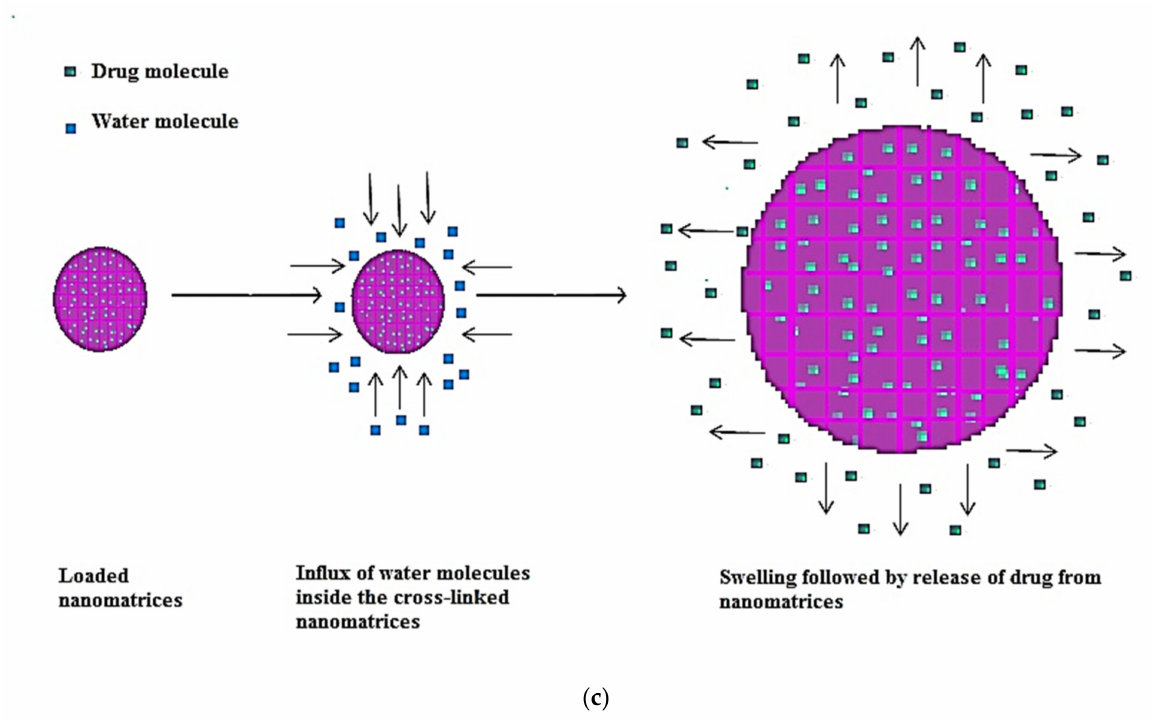
Figure 7. ( a ) Dissolution profile of the developed nanomatrices and pure drug in 0.1 N HCl (simulated gastric fluid) of pH 1.2. ( b ) Dissolution profile of the developed nanomatrices and pure drug in phosphate buffer (simulated intestinal fluid) of pH 6.8. ( c ) Mechanism of drug release from cross- linked